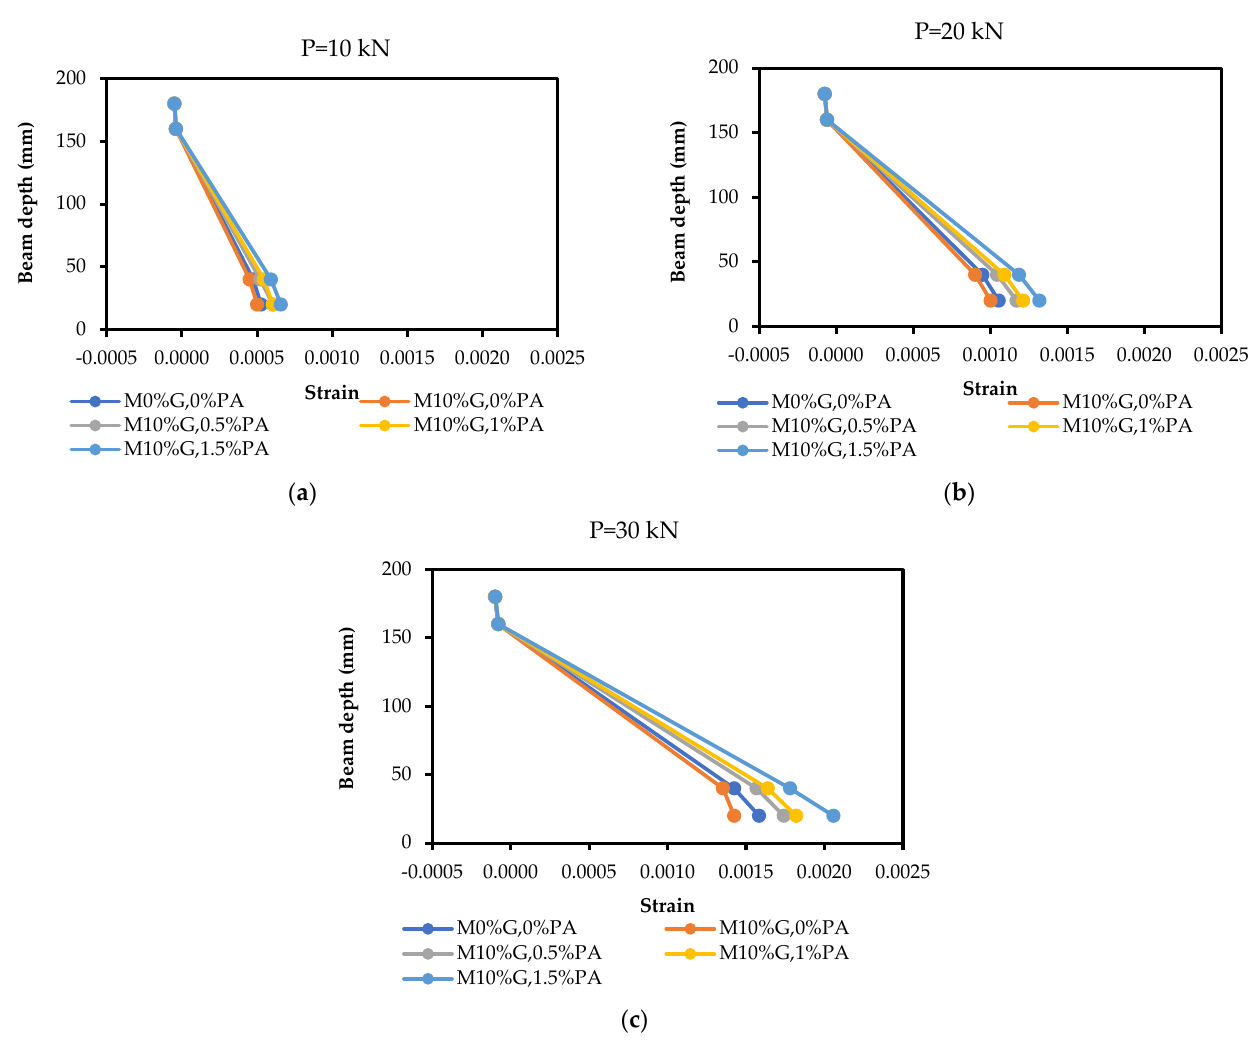
Figure 15. Strain measurements for beams; ( a ) 10kN load incrementation; ( b ) 20kN load incremen- tation; ( c ) 30 kN load incrementation.